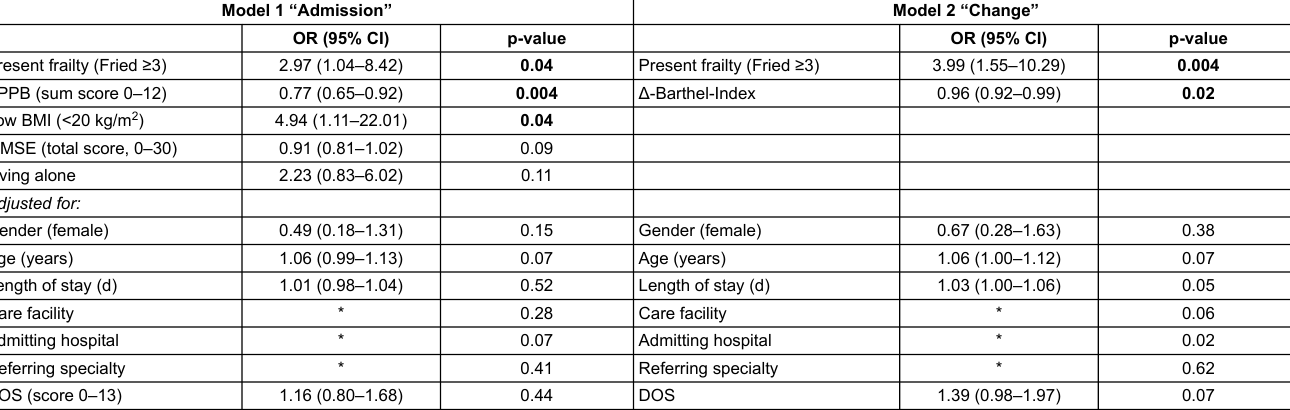
Table 2: Predictive models for